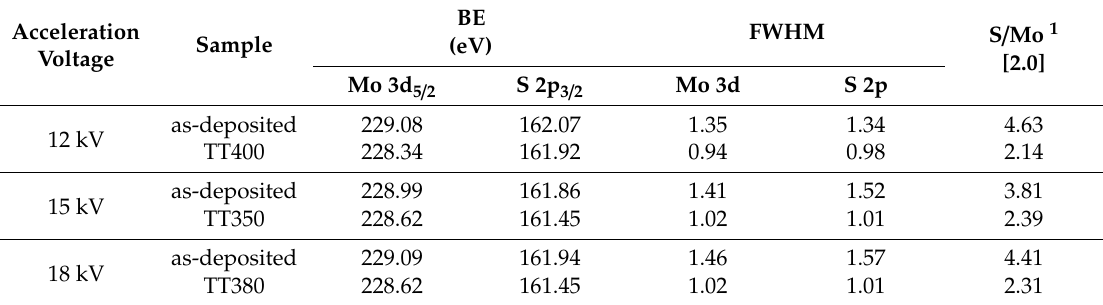
kV, and corresponding annealed samples